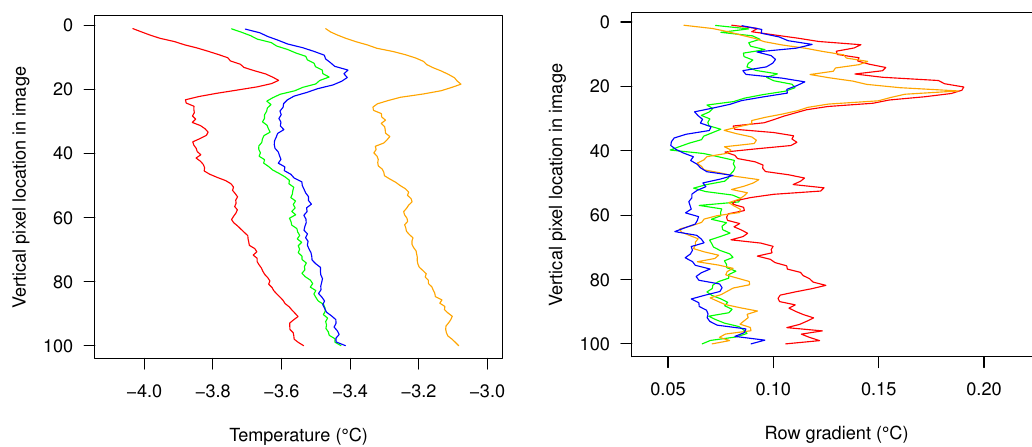
Fig. 3. (a) Temperature fluctuations over time, and (b) gradient fluctuations over time, from the same area. Both graphs have lines coloured in rainbow order of the time the photo was taken. Red first, then orange, then green, then blue. The time between the red line image and the blue line image is approximately one minute, whereas the red and orange images are approximately ten seconds apart at most.